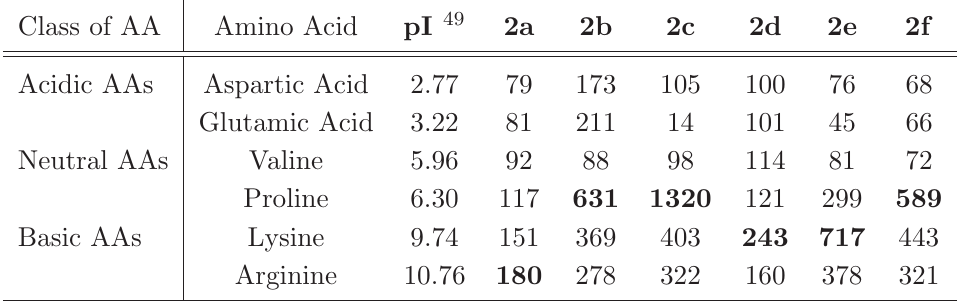
Table 1 Intensity of the fluorescence of the reaction products (in conditions mentioned in Figure 1) between the six amino acids and the six compounds 2a – 2f ( λ ex = 480 nm, λ em = 540 nm), arbitrary units